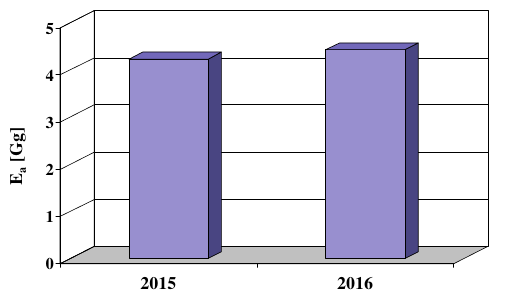
Fig. 6. National annual emission of methane from motor vehicles in 2015 and 2016